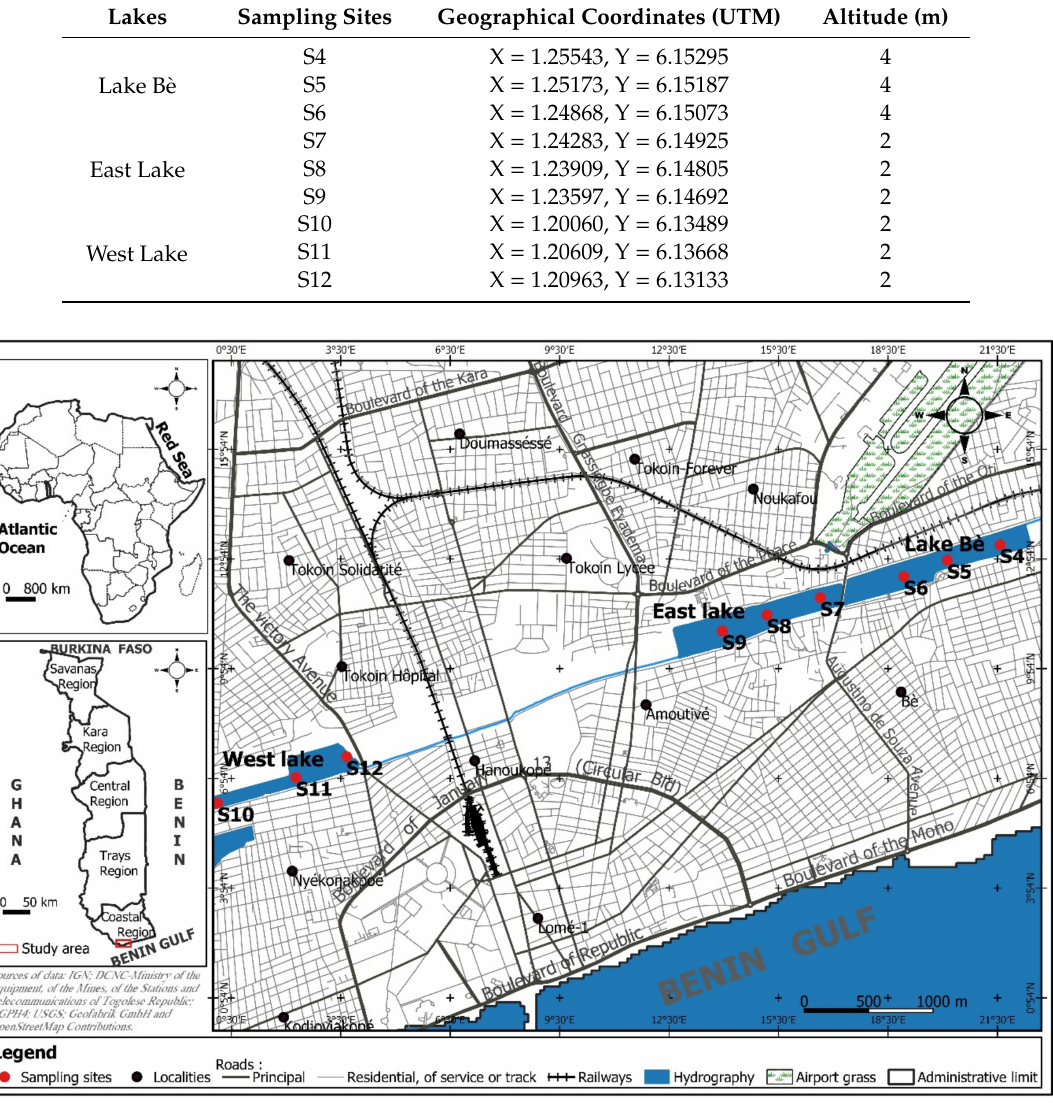
Figure 1. Geographic location of the Lakes and sampling sites in the study area of Lom é urban